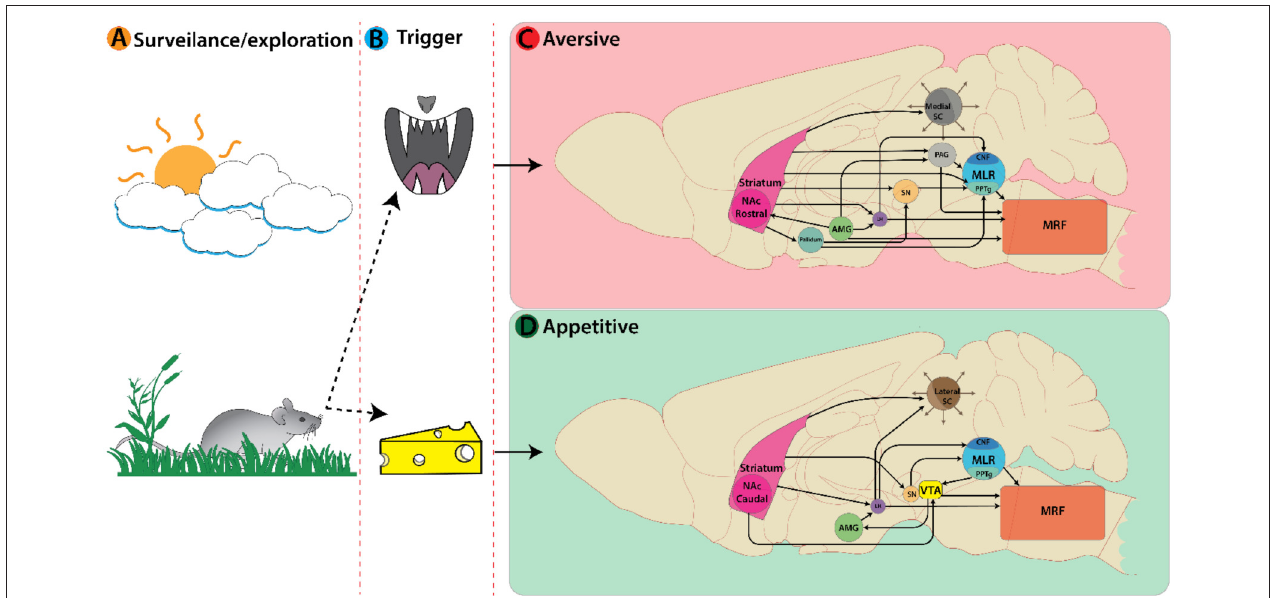
FIGURE 2 | Active nuclei in the mouse brain following a decision or trigger from a surveillance state. (A) Representation of an animal’s decision process during a surveillance state. In this example a mouse encounters an aversive trigger ( B top, predatory threat) activating nuclei associated with avoidance behaviors (C) . Main nuclei active here are: Striatum, Amygdala, Superior colliculi, etc. On the bottom (B) the mouse encounters an appetitive trigger of food/cheese activating nuclei associated with approach behaviors (D)